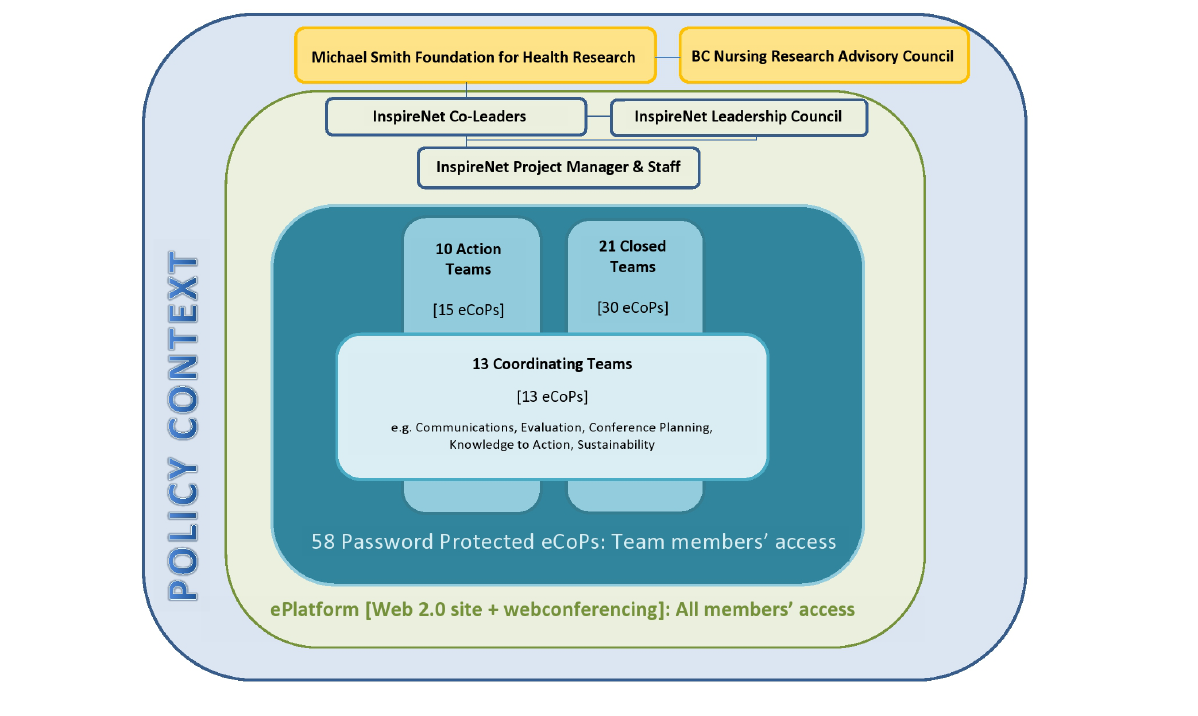
Figure 3. Network